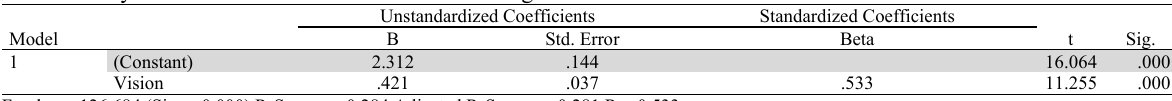
The summary of the effect of vision on decision-making